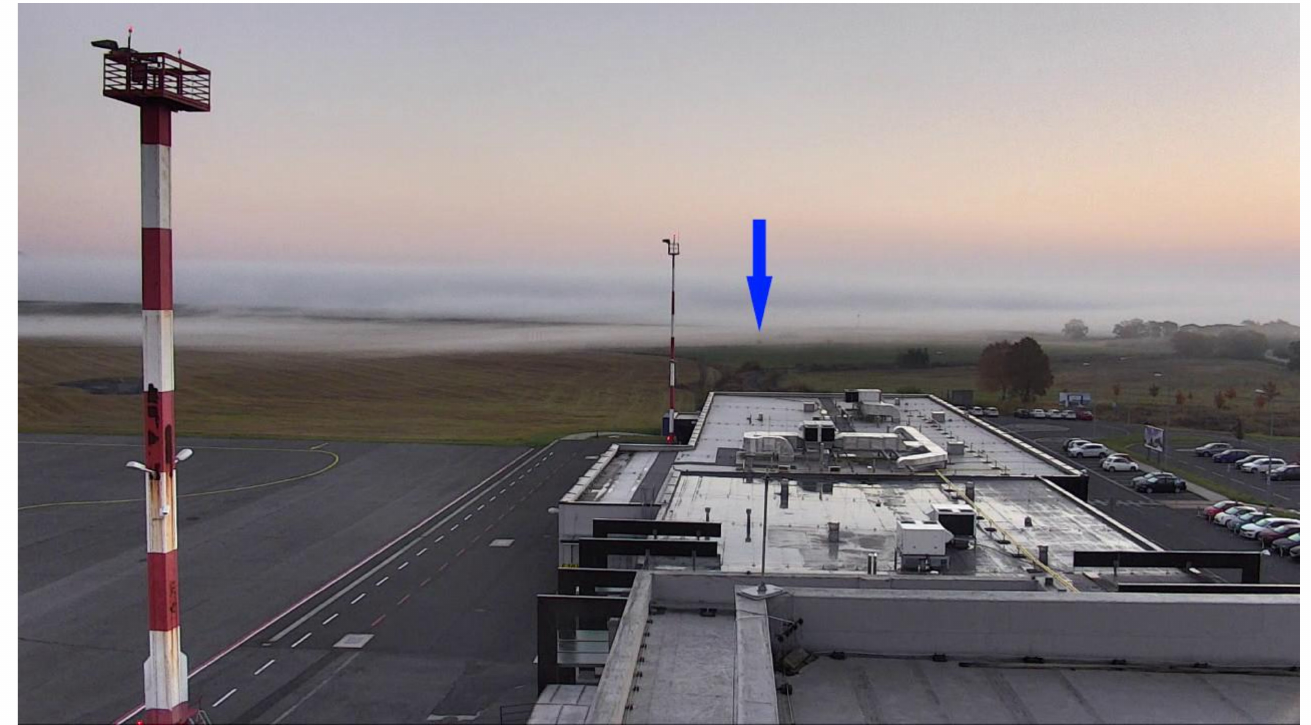
Figure 2. An example to illustrate the drawbacks of point measurements of visibility. Here, the visibility meter (indicated by the blue arrow) gets hidden in a fog patch and reports decreased visibility, but the overall prevailing visibility is